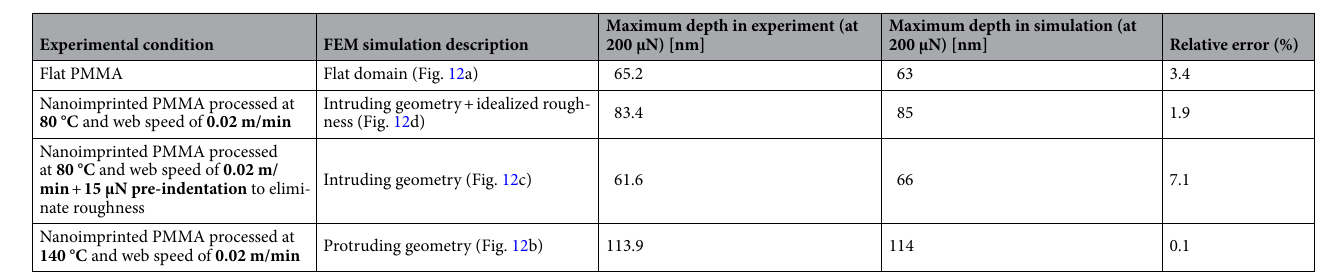
Table 1. Simulation and experimental conditions of the nanoindentation tests, showing maximum depths and relative